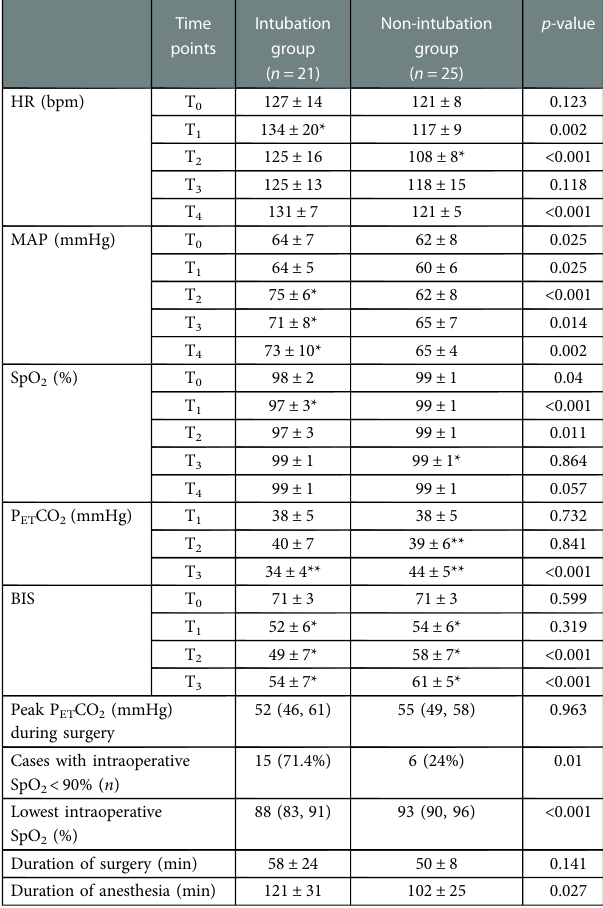
TABLE 2 Comparison of perioperative vital signs between the two groups.